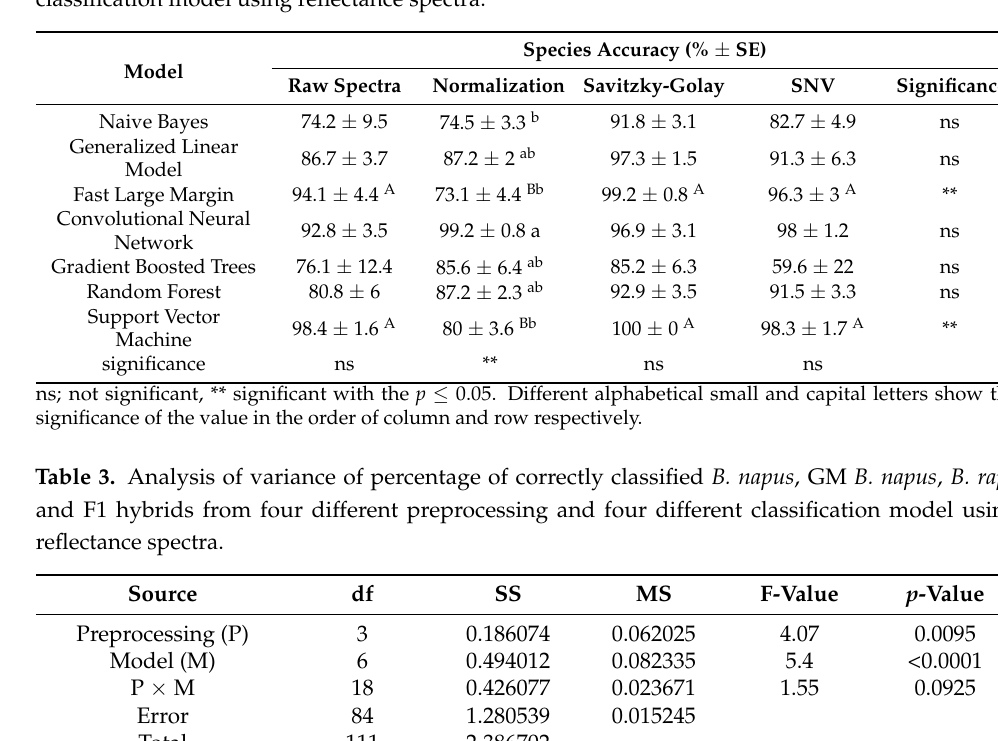
Figure 3. Linear Discriminant Analysis for the effective discrimination of B. napus , GM B. napus , B. rapa and F1 hybrids shown without confidence circles (A) and with confidence circle (B). Table 2. Means of percentage of classification accuracy of different preprocessing and different classification model using reflectance spectra.